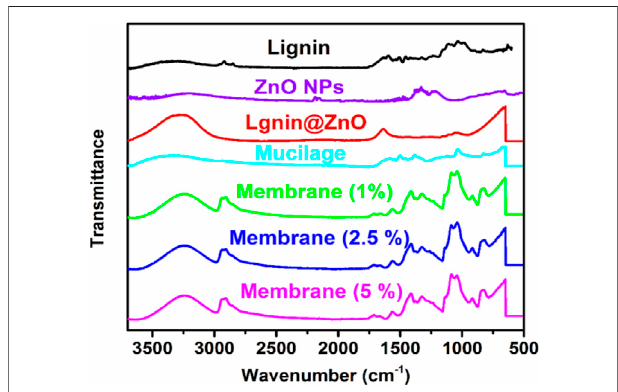
FIGURE 1 | FTIR spectra of lignin, ZnO NPs, Lignin@ZnO, mucilage, 1, 2.5, and 5% Lignin@ZnO-GTR